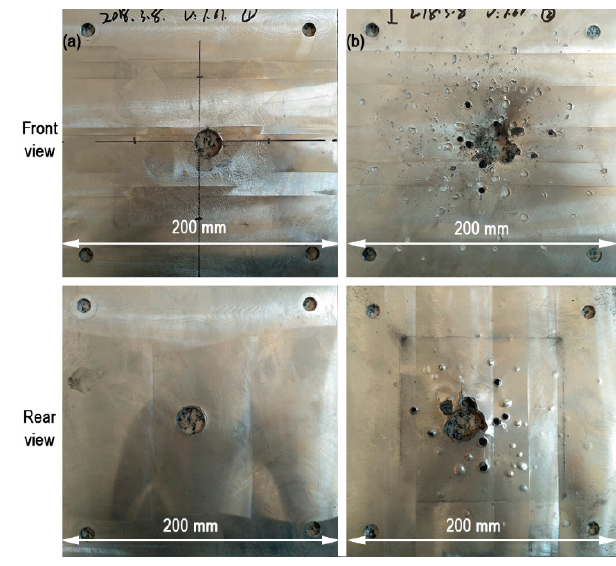
Figure 5. The experimental result of the bumpers (configuration A-3—( a ) Bumper I; ( b ) Bumper II).